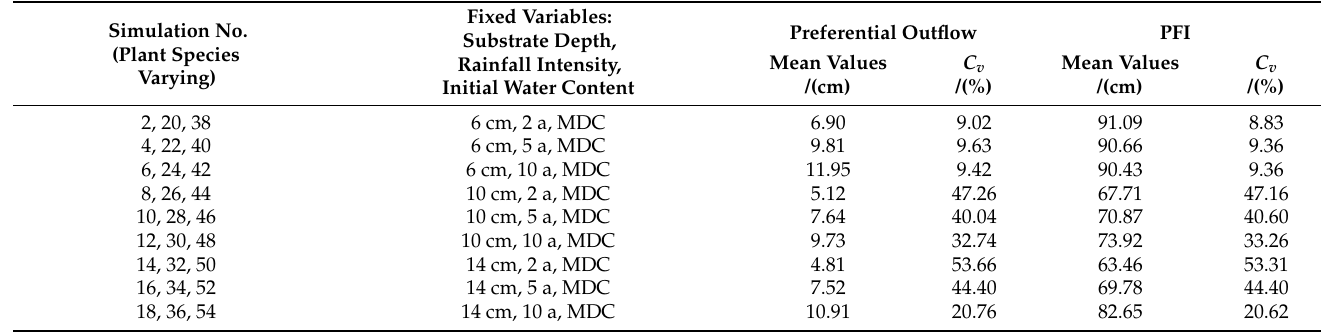
Table 9. Mean values and C v of PAS preferential outflow and PFI for different plant species.